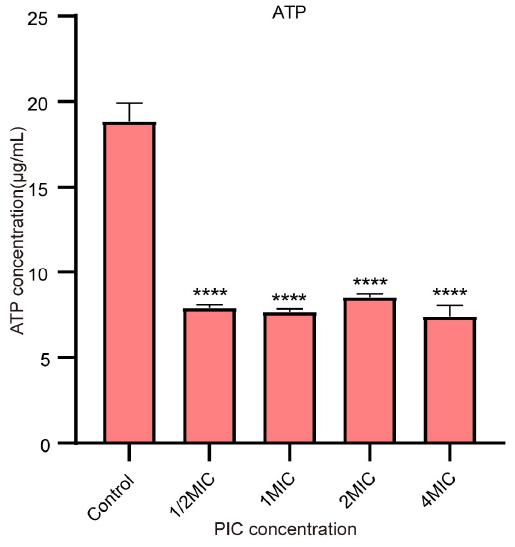
Figure 6. Intracellular ATP content of S. aureus treated with different concentrations of PIC. n = 3. Results from all experiments are presented as the mean ± SD of three replicates. **** = p < 0.0001.